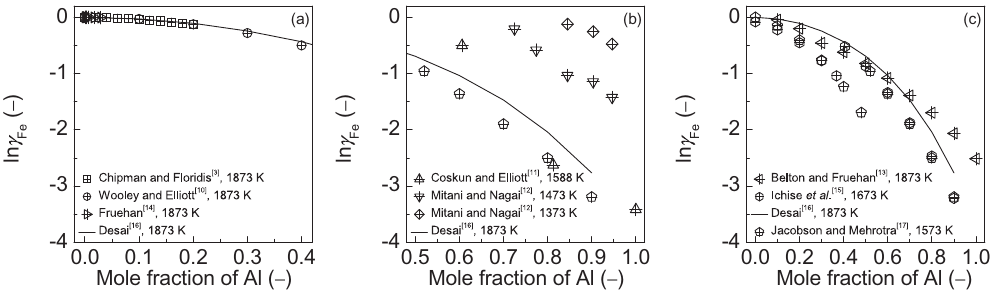
of Fe relative to pure liquid Fe(l) as standard state for three Fe